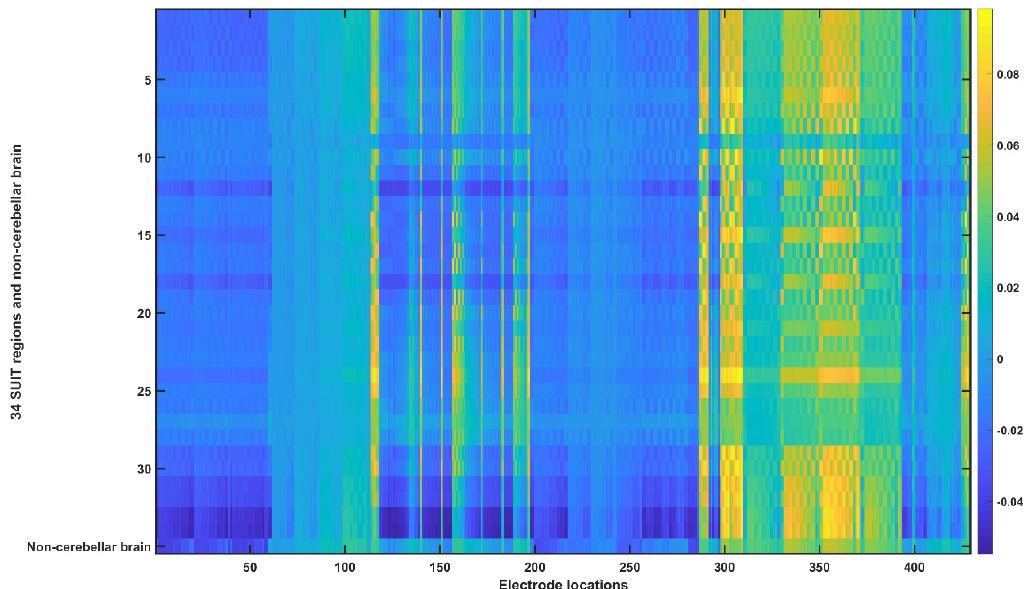
Figure A5. Ey transfer matrix for the head model from the 55–59 years old MRI template. The X-axis shows the electrode locations (refer Appendix B) and Y-axis shows the 34 SUIT regions (refer Appendix A) and non-cerebellar brain.